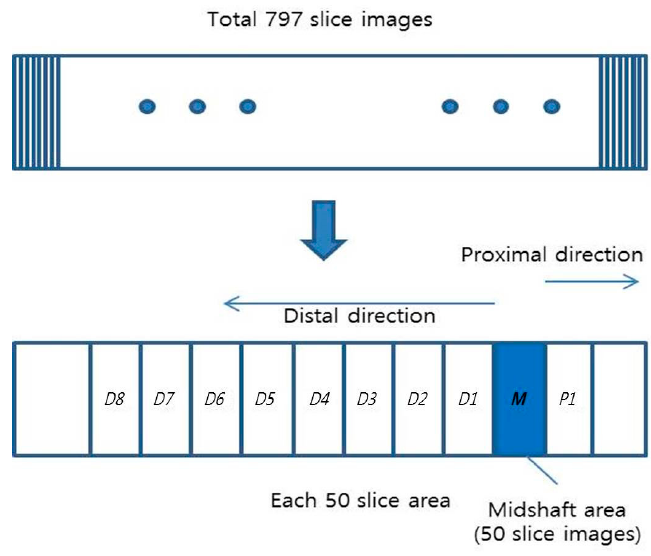
Figure 2. The obtained slice images were grouped into 10 regional areas, each with 50 slice images.